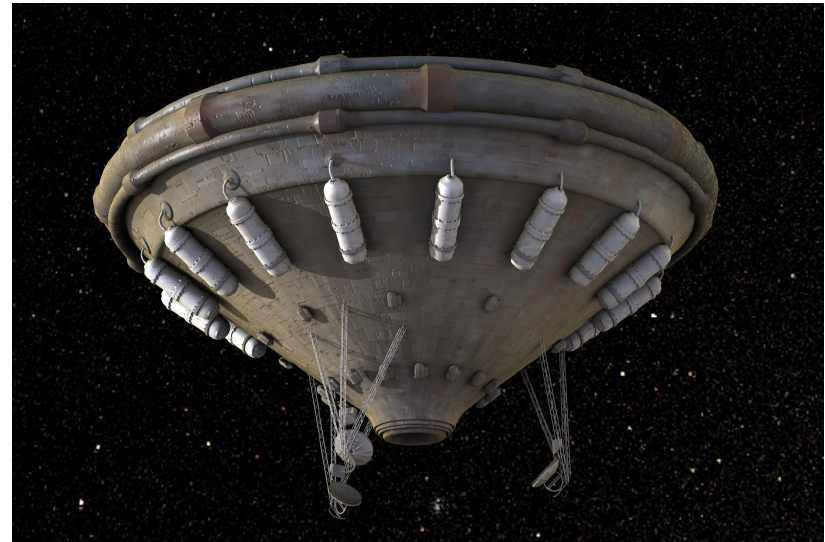
Figure 9. The Vista spacecraft concept